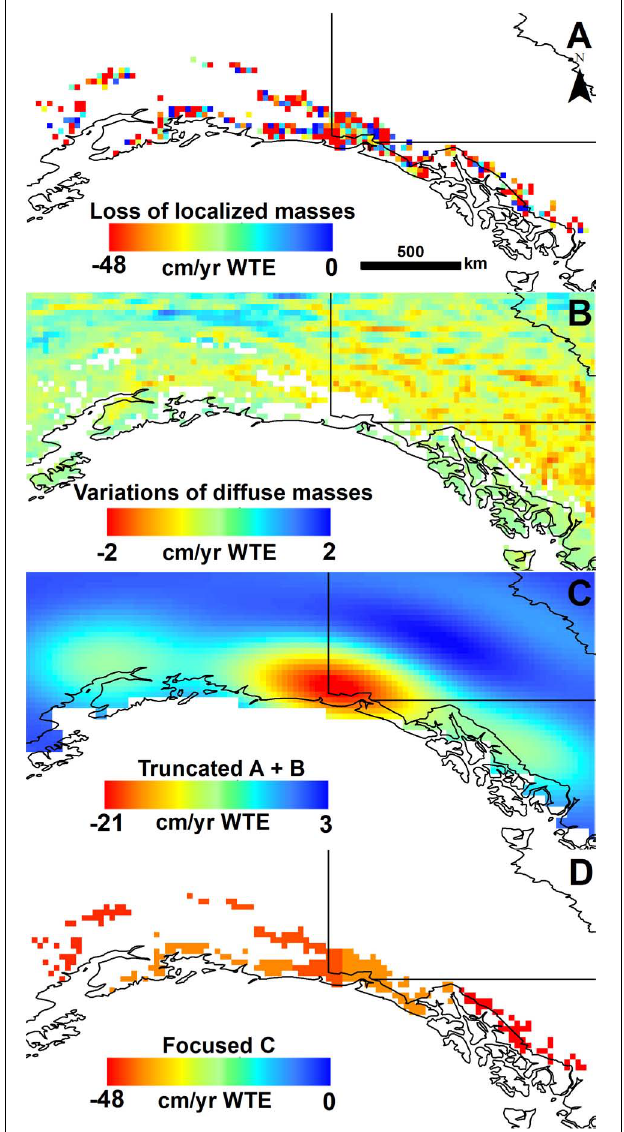
FIGURE 3 | (A) Synthetic mass randomly allocated to pixels corresponding to glaciers. (B) Soil moisture trend from GLDAS Noah Land Surface Model (LSM) v2.1. (C) Forward model (FM) of A overlaid on B , representing a realistic reproduction of the GRACE trend signal derived from known masses. It includes both concentrated and diffuse mass changes in realistic proportions. (D) Example of a high resolution glacier mass loss map retrieved by applying the inversion procedure over C and using the 5-mascon delineation shown in Figure 2A . This synthetic test allows to assess the inversion procedure